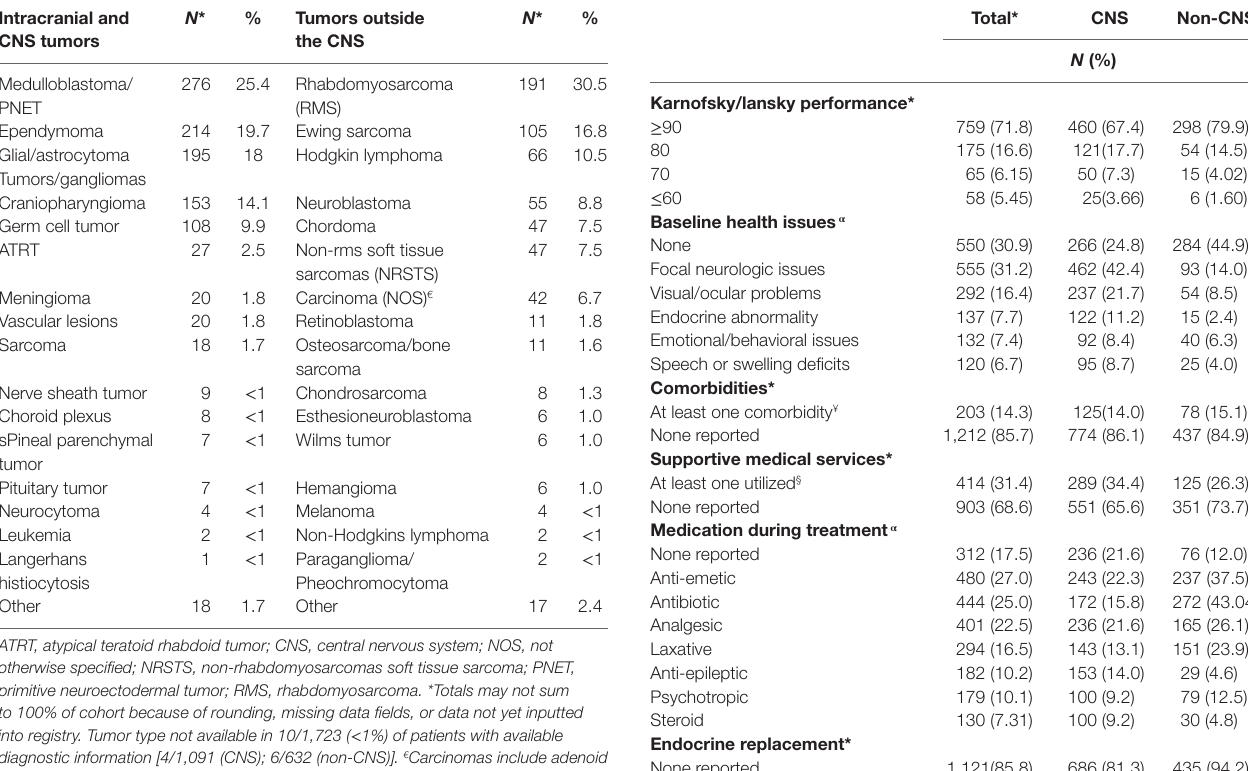
TaBle 3 | Primary diagnosis tumor type. TaBle 5 | Baseline health information.